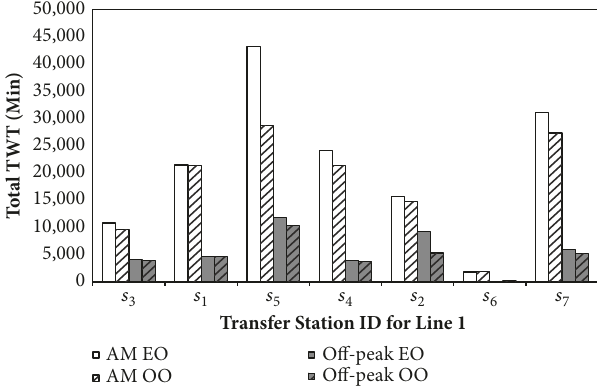
Figure 8: Total TWT with EO and OO at various transfer stations.